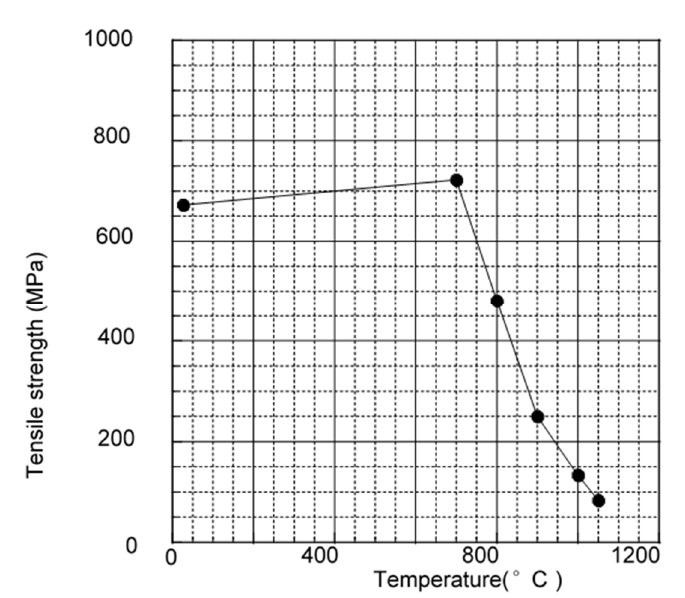
Figure 6. Tensile strength of hot-forged Ti-42Al-5Mn after heat treatment as a function of tempera- ture.